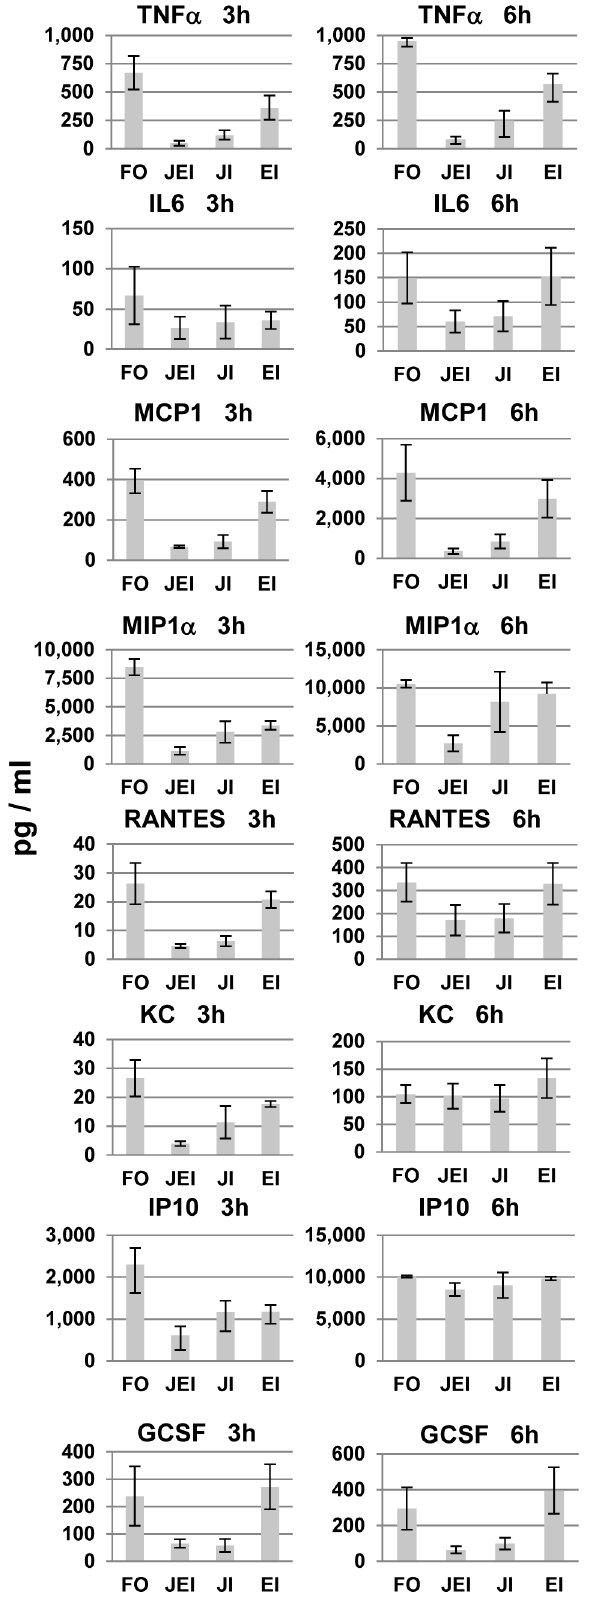
Figure 7. Effects of MAPK inhibitors on FLUA-induced CK/CHK from RAW 264.7 cells at short time points. Supernatants from cells treated with the indicated inhibitors as described in Methods then exposed to FLUA were collected 3 or 6 h after exposure, along with those from mock infected controls. They were assayed for selected CK/ CHK by multiplexed fluid phased antibody based analysis. Cytokine concentrations were calculated based on known concentration standards run at the same time. Data shown are the mean 6 SEM, n=3 independent experiments. FO–FLUA only; JEI–both JNK and ERK Inhibition; JI–JNK inhibition; EI–ERK